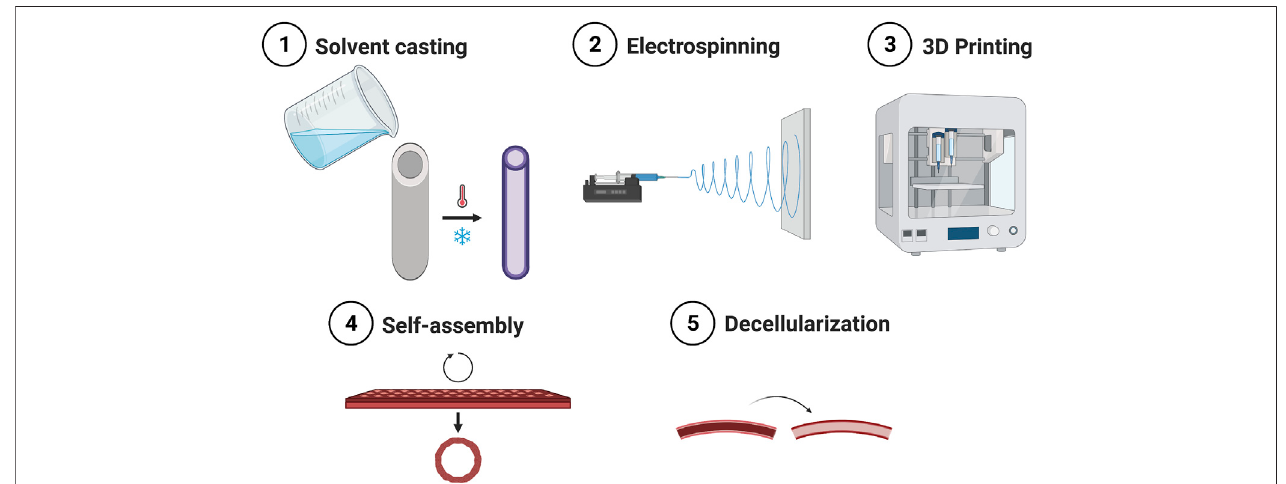
FIGURE 3 | Main methods for the fabrication of small caliber vascular